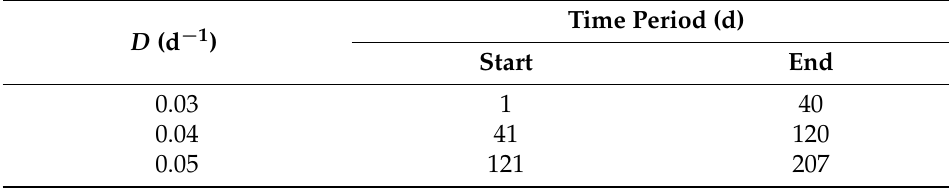
Table 1. Dilution rate values of the